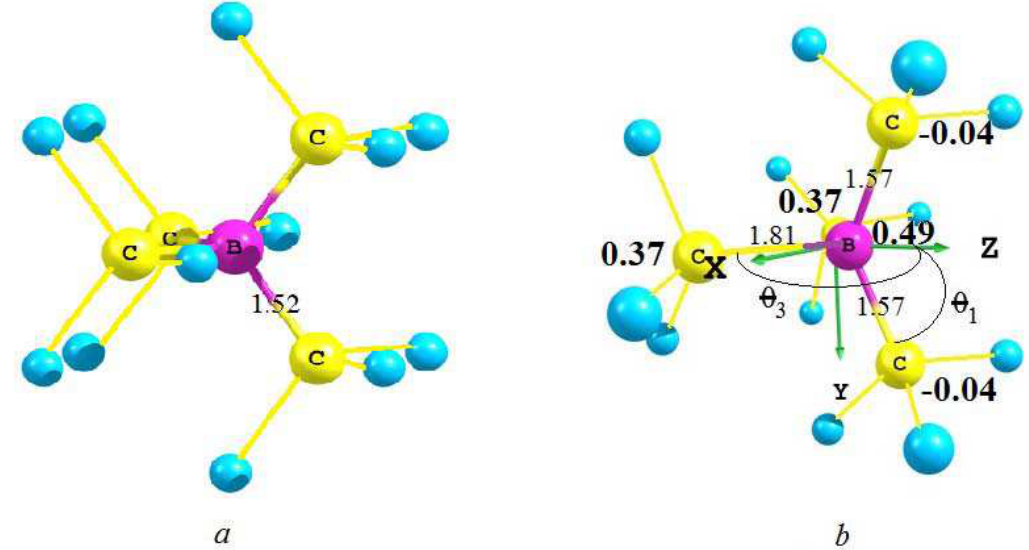
Figure 2. Structure of the radiation ( µ B) + defect in a diamond lattice: ( a ) the ( µ BC 4 ) + cluster has a T d symmetry in the initial triplet state; ( b ) it has a lower C 2 v symmetry with angles θ 1 = 65 ◦ and θ 3 = 128 ◦ in the final triplet state. The internuclear distances are given in Å. The spin densities on atoms are marked by bold